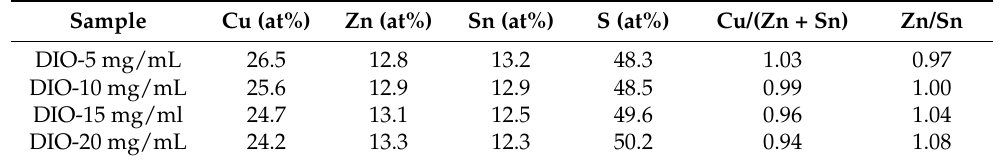
Table 1. Elemental composition of Cu 2 ZnSnS 4 (CZTS) thin films fabricated using different 1,8-diiodooctane (DIO) additive concentrations.